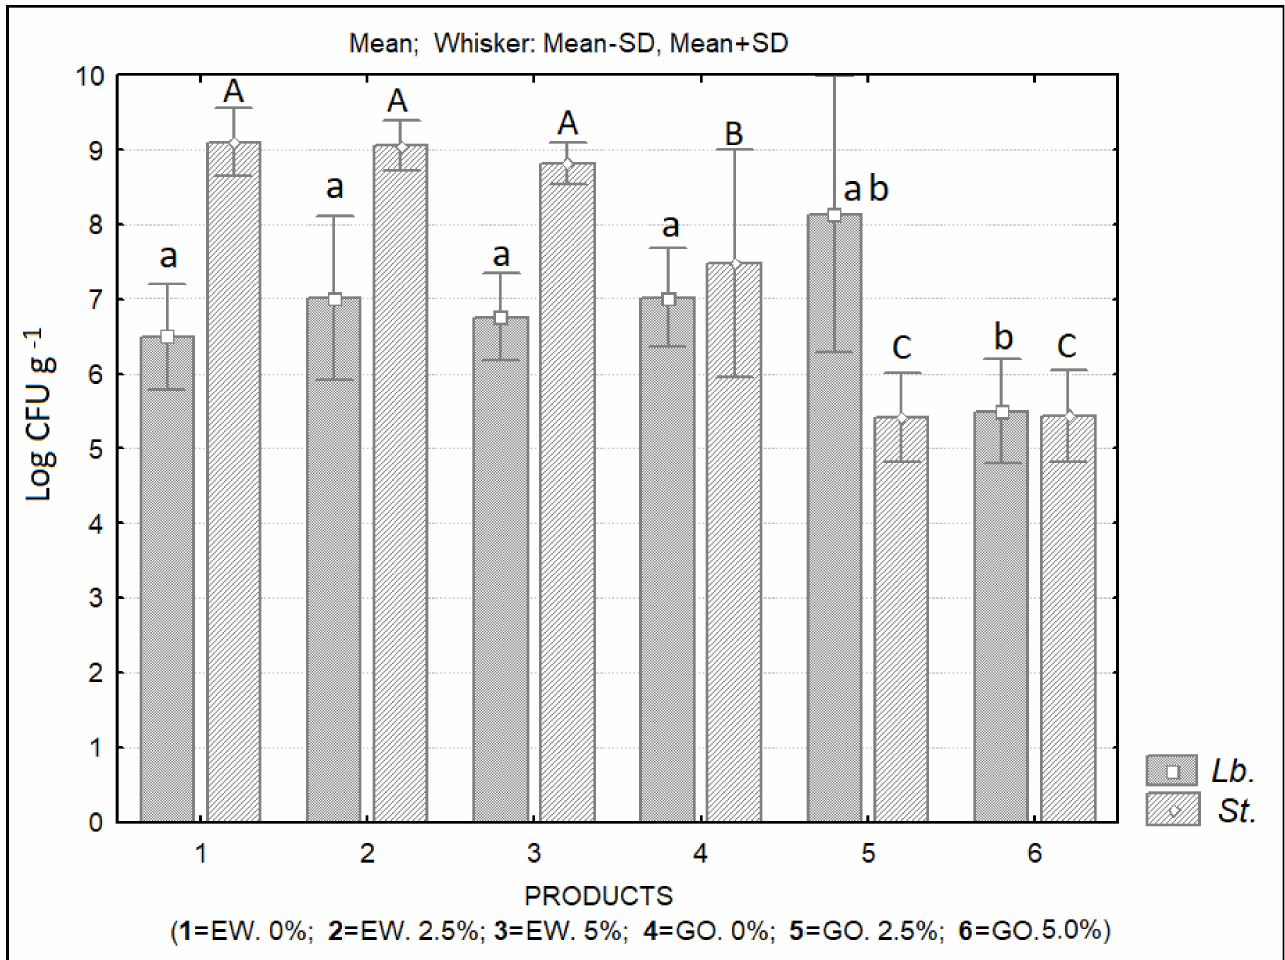
Figure 7. Lactobacilli sp. ( Lb.) and Streptococci sp. ( St.) counts (log CFU g − 1 ) of ewe’s and goat’s frozen yoghurts produced with UF concentrated cheese whey at the day of production (EW. 0% = ewe’s yoghurt with 0% inulin addition; EW. 2.5% = ewe’s yoghurt with 2.5% inulin addition; EW. 5.0% = ewe’s yoghurt with 0% inulin addition; GO. 0% = goat’s yoghurt with 0% inulin addition; GO. 2.5% = goat’s yoghurt with 2.5% inulin addition; GO. 5% = goat’s yoghurt with 5% inulin addition). Different superscript letters indicate significant differences ( p < 0.05) between products for lactobacilli (a, b, c) and streptococci (A, B, C)